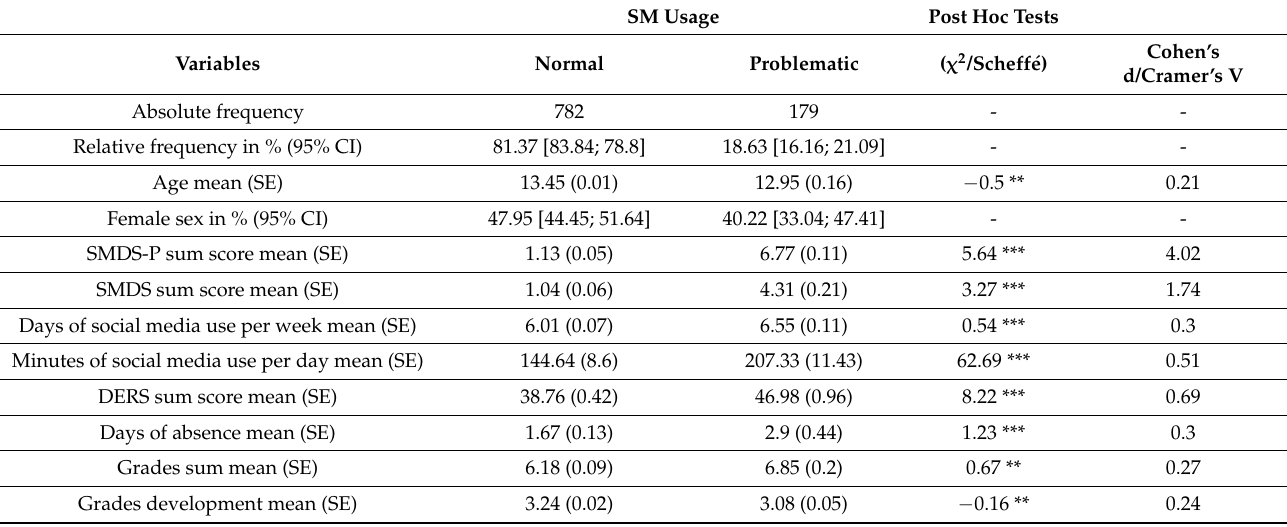
Table 3. Post hoc MANOVA and between the group tests of SM usage